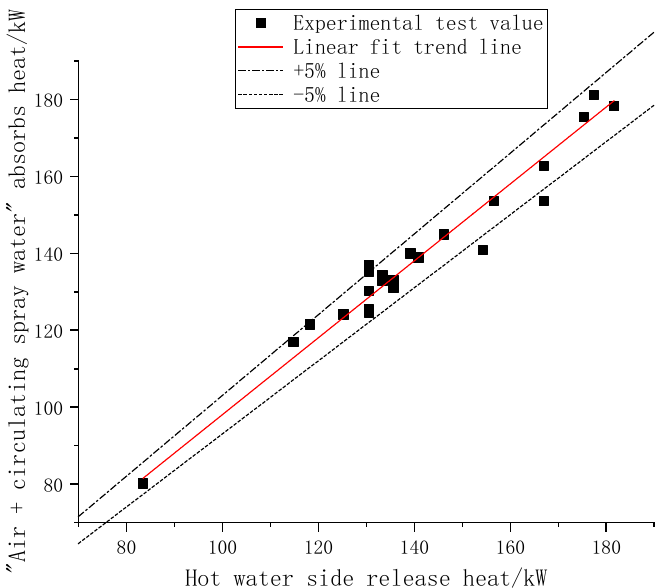
Figure 5. Comparison of heat balance analysis.